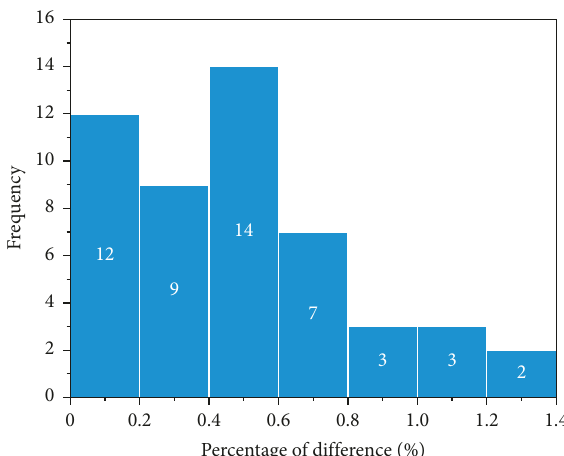
Figure 4: Distribution of the difference between the lengths of the shortest paths obtained by the two methods in